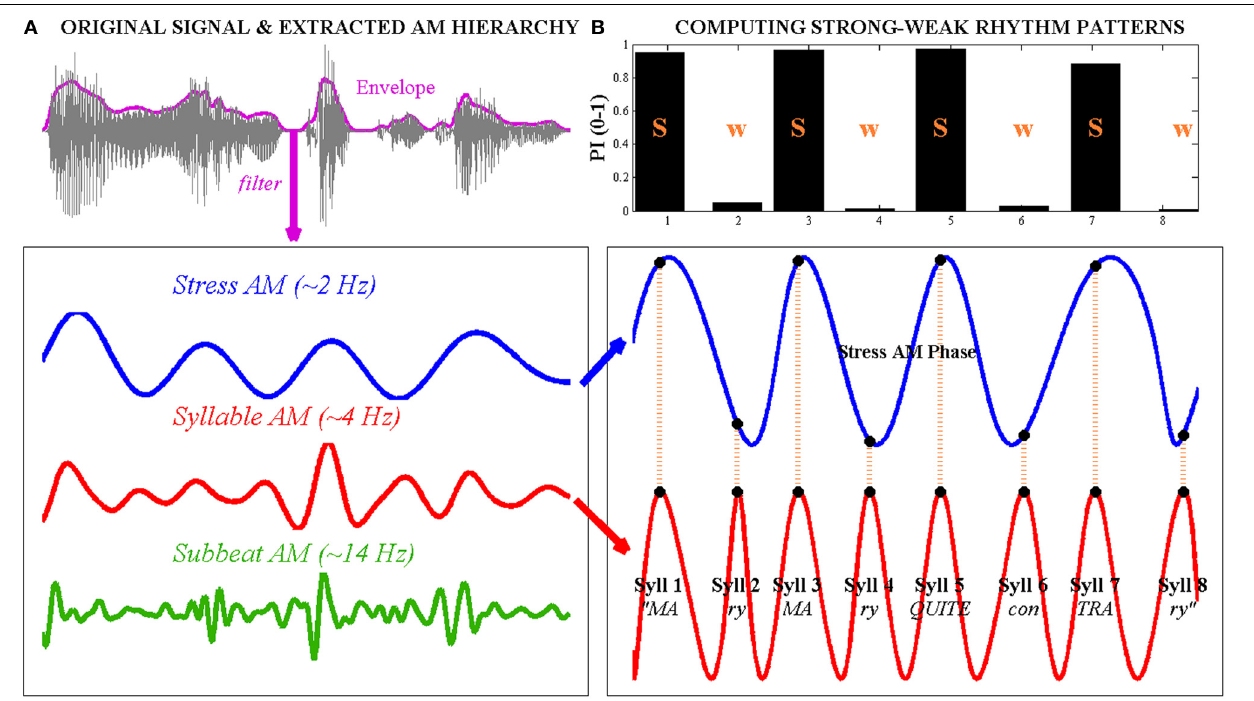
FIGURE 1 | Computation of strong-weak (s-w) syllable stress patterns using the phase-relationship between “Stress”- and “Syllable”-rate amplitude modulations (AMs) in the speech envelope, illustrated with the trochaic (s-w) nursery rhyme sentence “Mary Mary quite contrary.” Left, (A) the original waveform of the speech signal is shown at the top, with the whole-band amplitude envelope superimposed as a bold line. The envelope is band-pass filtered at three different rates to produce a Stress AM ( ∼ 2Hz), a Syllable AM ( ∼ 4Hz) and a Sub-beat AM ( ∼ 14Hz) respectively. Right, (B) to compute the syllable stress pattern of the sentence, the oscillatory phase series of the Stress AM and the Syllable AM are extracted. Here, AM phase values are projected onto a